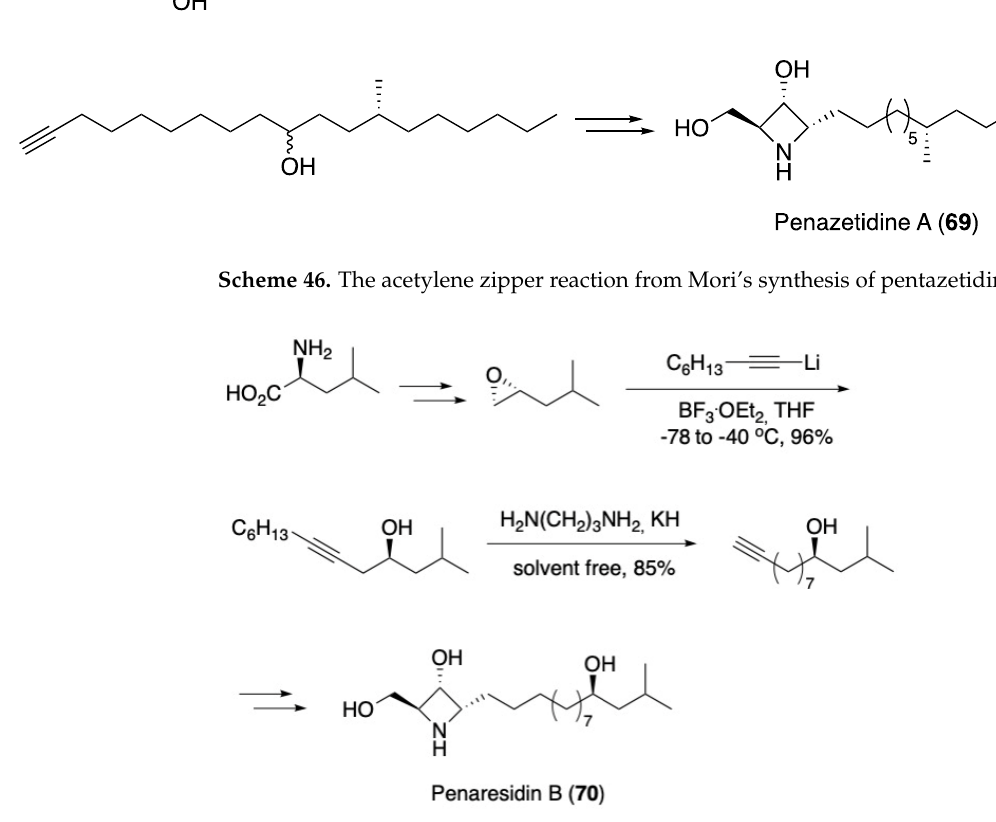
Scheme 47. The synthesis of penaresidin B ( 70 ) [109]. Amiclenomycin ( 71 ), isolated from cultures of different Streptomyces strains, is a potent mechanism-based inhibitor of BioA. However, due to amiclenomycin’s low chemical stability, development of analogues is of interest. Structure of amiclenomycin is shown in Figure 7. was prepared using an alkyne zipper reaction as one of the key reactions, see Scheme 48 [110]. During biological testing, the compound demonstrated no biological activity.